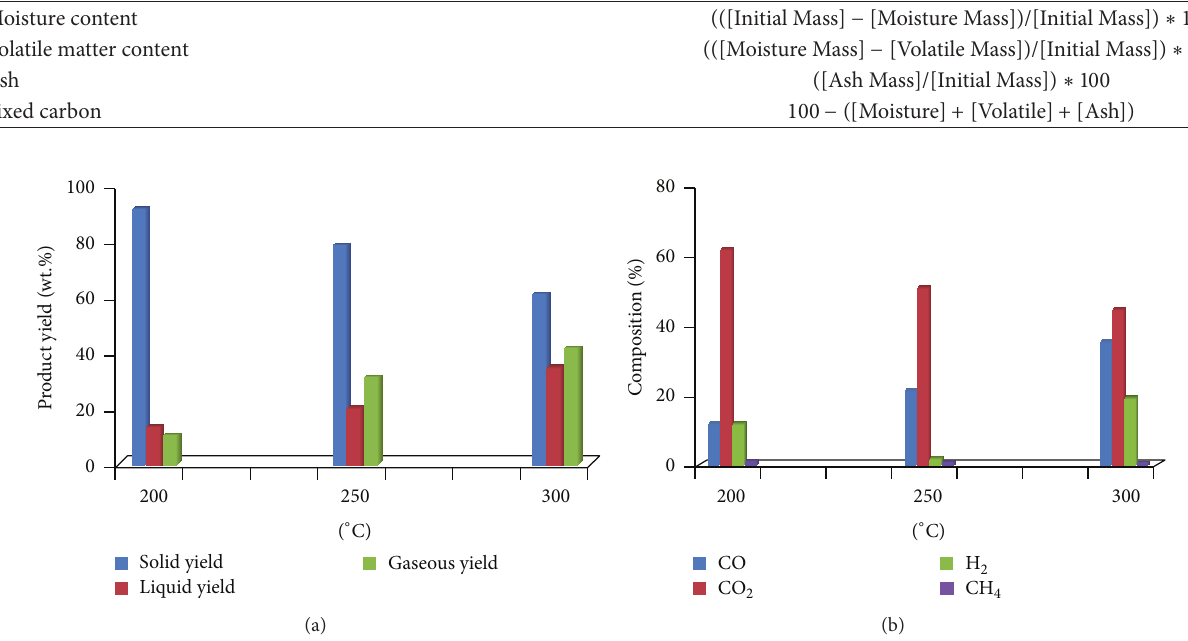
Figure 1: Impact of torrefaction on (a) the yield of products and (b) percentage composition of gaseous products formed from sugarcane bagasse torrefied at different